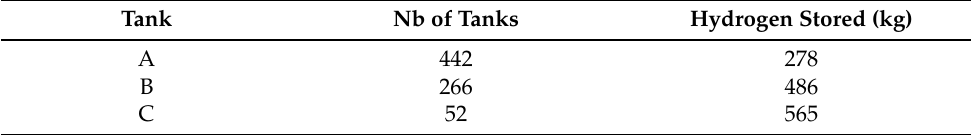
Table 3. Hydrogen storage capacity in a 20 ft